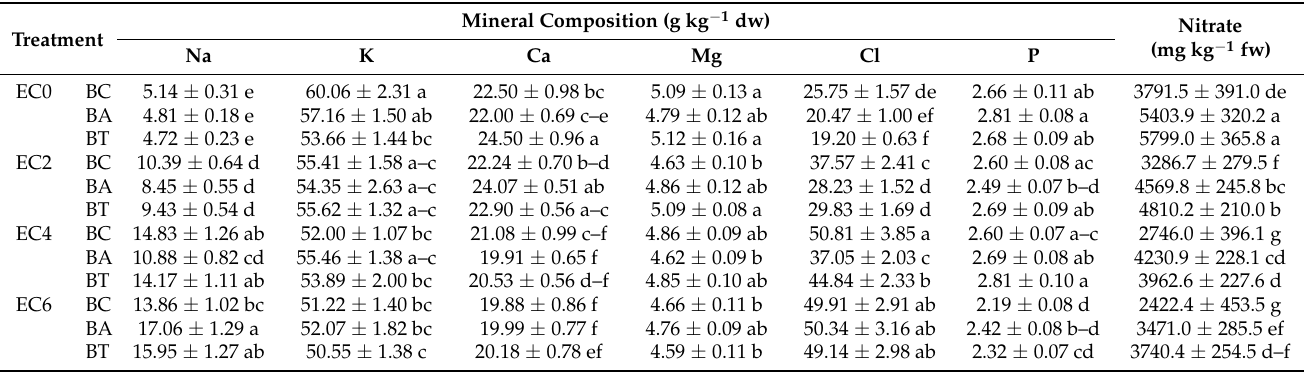
Table 5. Effect of salinity and biostimulant application on minerals (Na, K, Ca, Mg, Cl, and P) and nitrate content in Diplotaxis tenuifolia leaves, regardless of harvesting